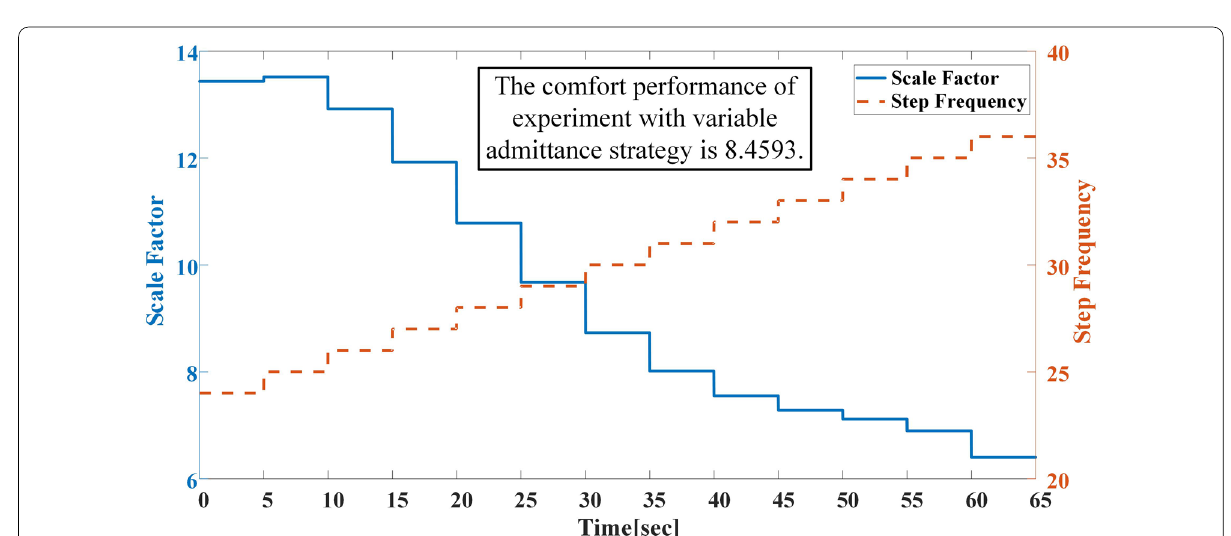
Figure 14 Variable scale factor β (23) and the transient walking frequency using the variable admittance controller in 65 s